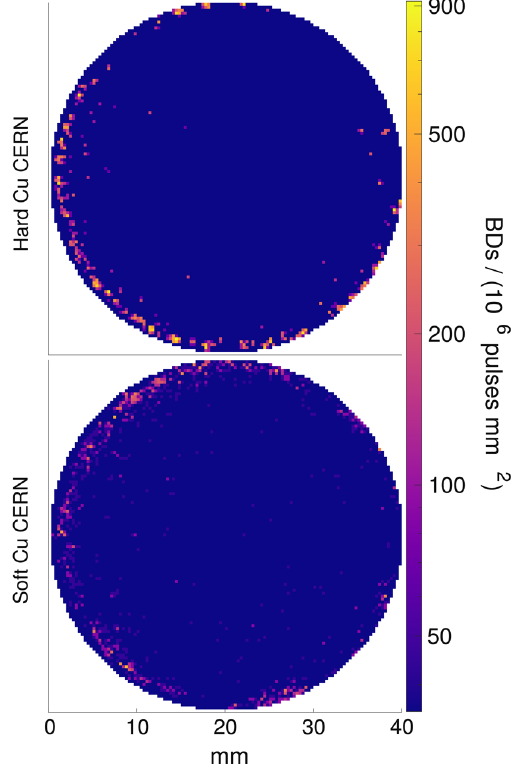
FIG. 10. Density graph of the breakdown positions on hard Cu CERN and soft Cu CERN. The plots show that on hard Cu, the BDs tend to appear in distinct sites, whereas on soft Cu, the clusters are not as strong and the distribution is more widely spread (leading to lower BD density). It is also important to note that on both electrodes, majority of the BDs lie on within a few millimeters from the edge.